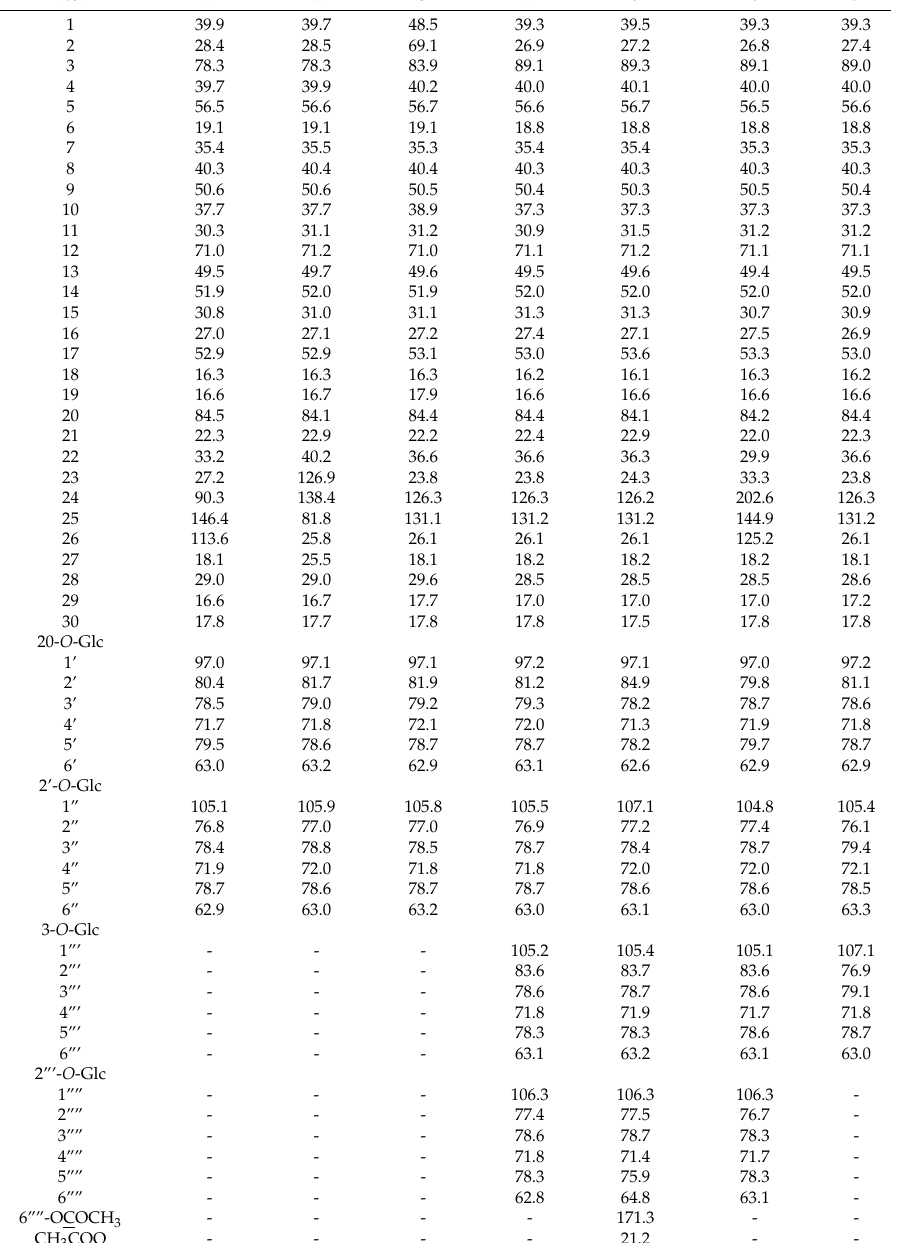
Table 2. 13 C-NMR data for compounds 1 – 6 , 9 (150 MHz, pyridine- d 5 , δ in